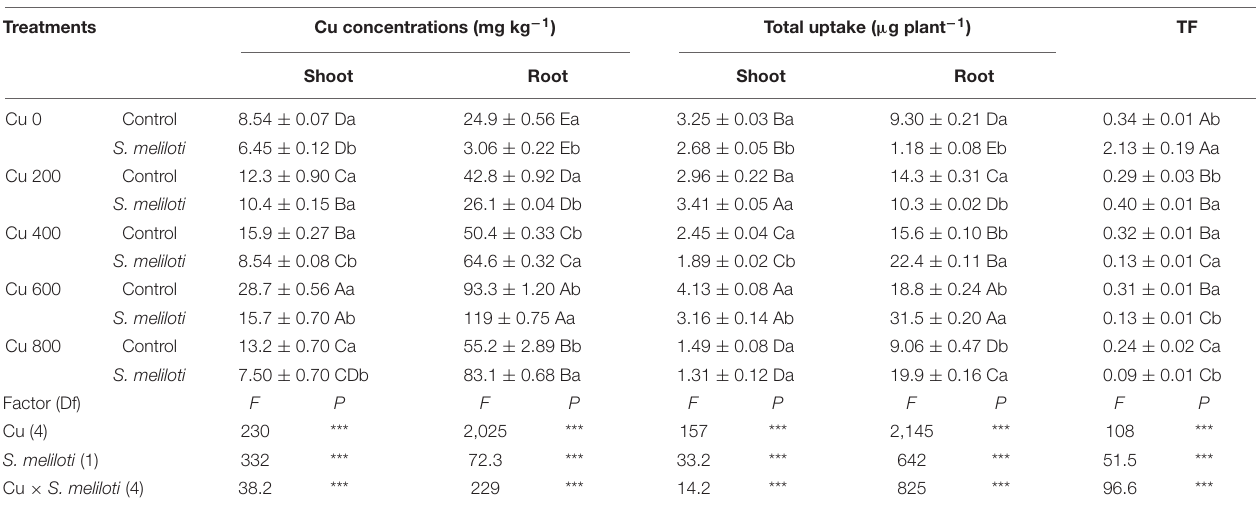
The capitalized letters indicate significant differences between different Cu concentrations, whereas the lower-case letters indicate significant differences between non- inoculated and inoculated alfalfa under the same Cu concentration condition (P < 0.05). TF (translocation factor: shoot concentration/root concentration). Each value represents the mean ± SE (n = 3). ∗∗∗ P <